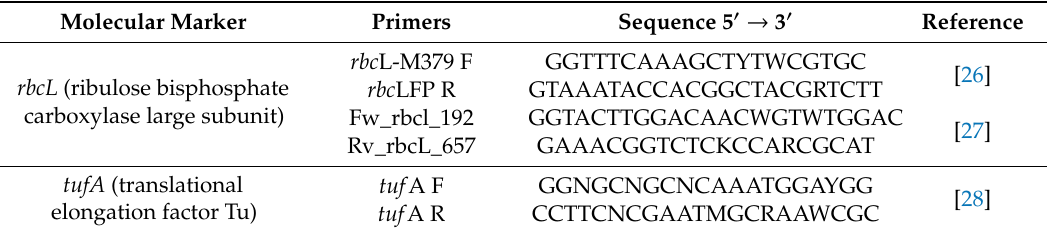
Table 1. List of primers used in this study to identify the strain